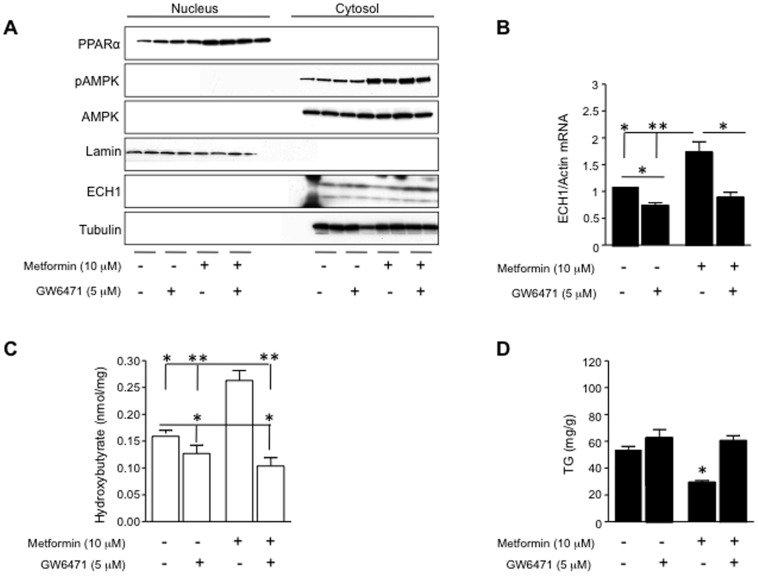
Metformin-induced up-regulation of ECH1 is mediated by PPARα.A) Representative western blot of nuclear and cytosolic extracts from hepatocytes exposed to metformin (10 µM) and the PPARα inhibitor, GW6471 (5 µM). As shown, GW6471 reduces metformin-induced ECH1 up-regulation in the cytoplasmic fraction but do not affet either PPARα nuclear expression or AMPK phosphorylation. B) ECH1 mRNA levels in hepatocytes exposed to metformin (10 µM) and the PPARα inhibitor, GW6471 (5 µM) C) Inhibition of PPARα activity with the antagonist GW6471 reduces metformin-induced fat oxidation. D) Inhibition of PPARα activity with the antagonist GW6471 reduces metformin-induced trigyceride accumulation. *p<0.05, **p<0.01.